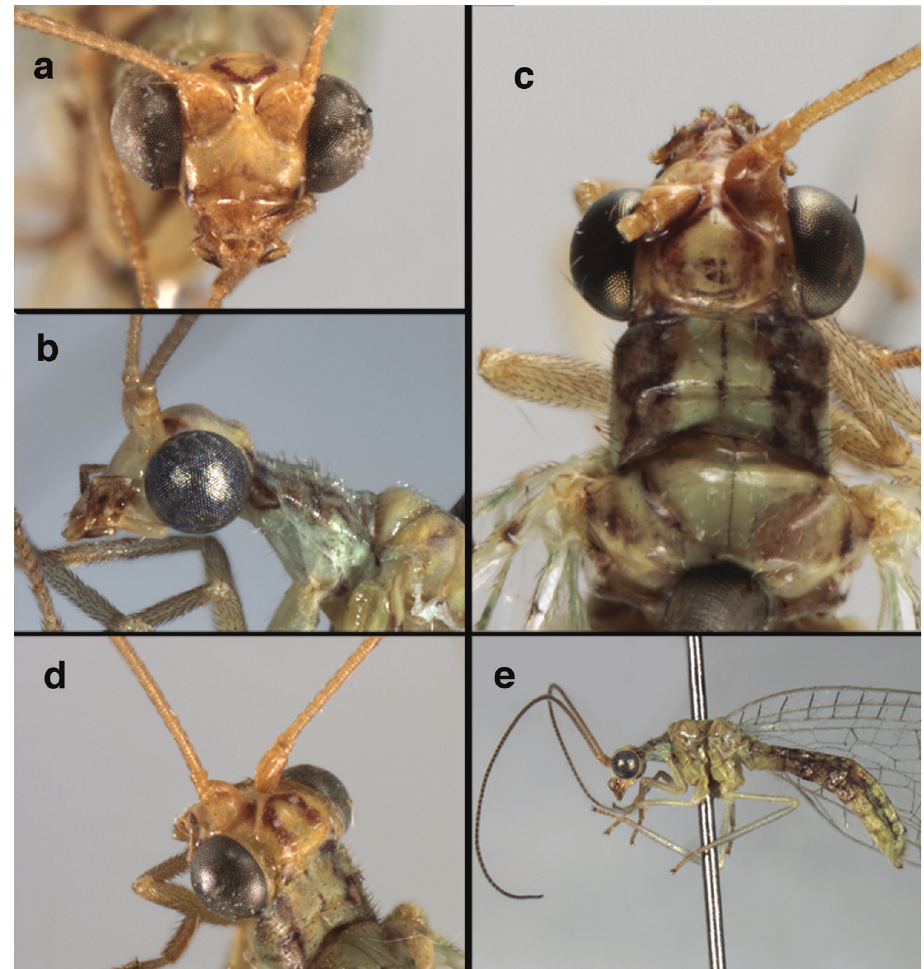
Figure 126. Ungla confraterna (Banks): External features, ( a ) head, frontal ( b ) head, prothorax, lateral ( c ) head, prothorax, mesothorax (partial), dorsal ( d ) head, prothorax, dorsolateral, antennal fossa ( e ) body, lateral (Argentina; a, c, d Mendoza, female, USNM; b, e La Rioja, male, FSCA).